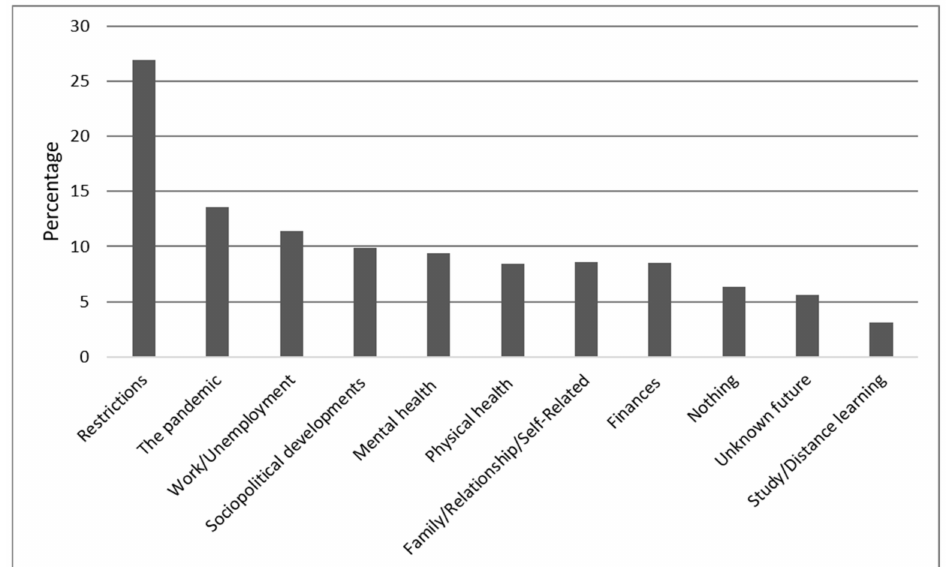
Figure 2. Sources of current concerns. The percentages of participants reporting each main category of concerns that emerged from the data for the second question: “What is currently causing you the greatest concern?”.